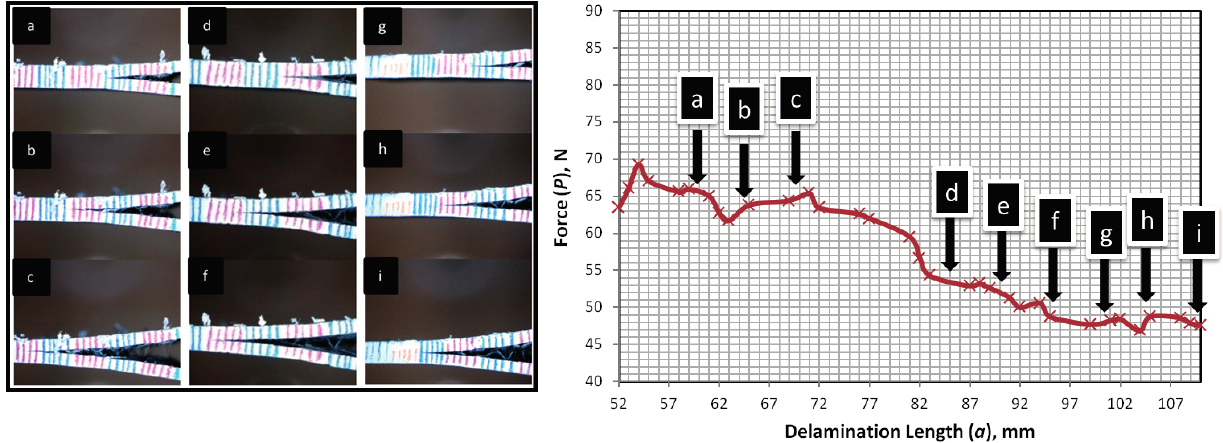
Figure 6. The crack propagation observed in a 1.0 wt% COOH–MWCNTs CFRP composite ( left ) with the associated load-displacement behavior ( right